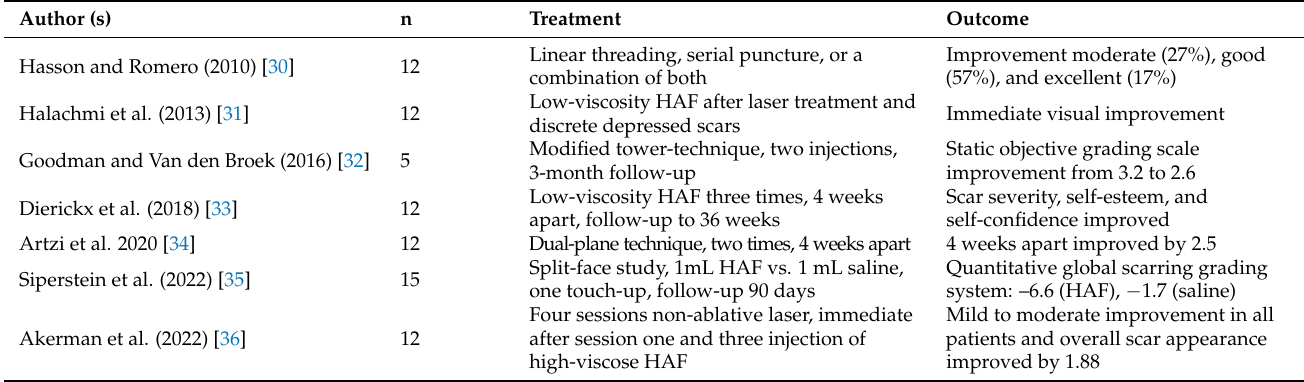
Table 3. HAF to correct acne